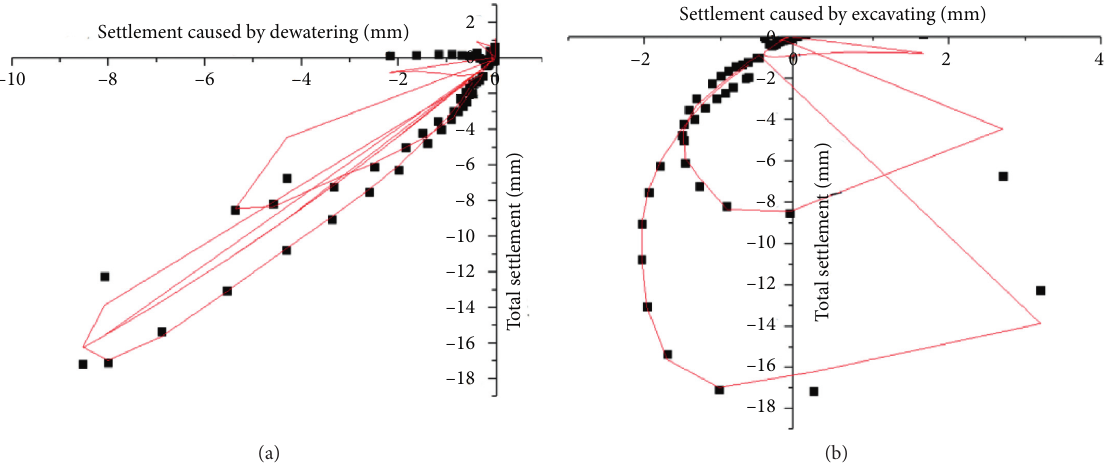
Figure 11: Fitted curve between the total settlement and settlement caused by dewatering and